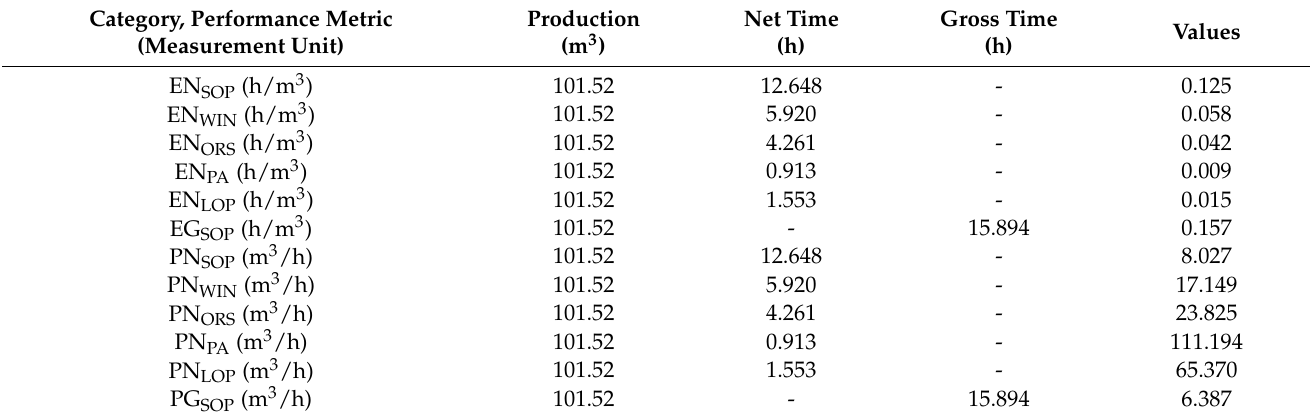
Table 10. Estimates of Net and Gross Efficiency and